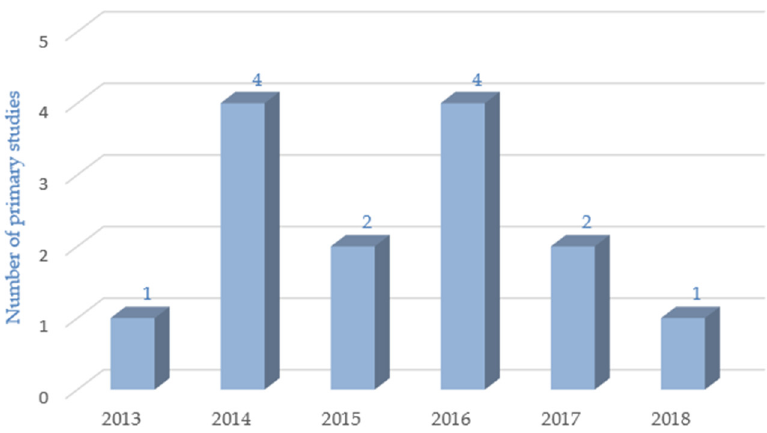
Figure 2. Number of primary studies by year.